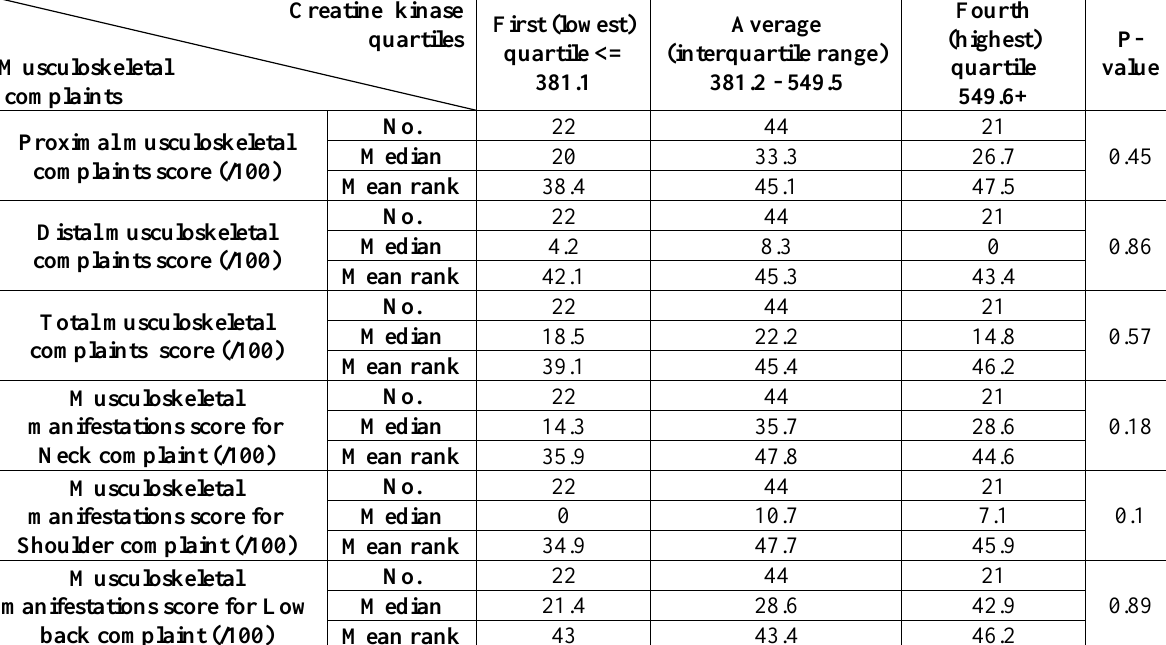
Table 5: Musculoskeletal complaints according to salivary Creatine kinase quartiles: Creatine